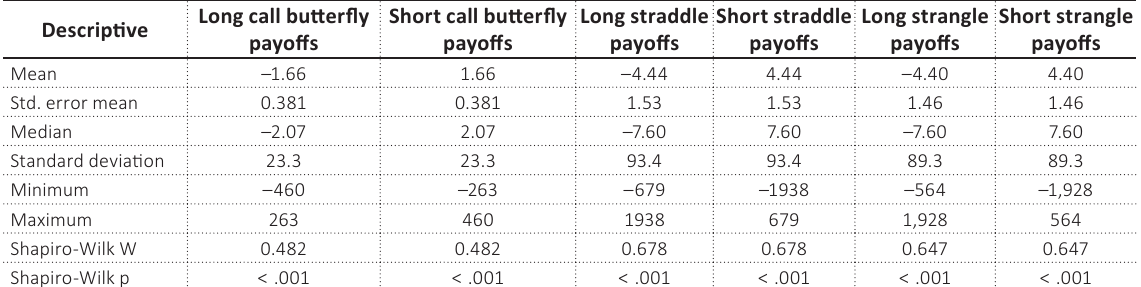
Table 1. Descriptive statistics of option strategies